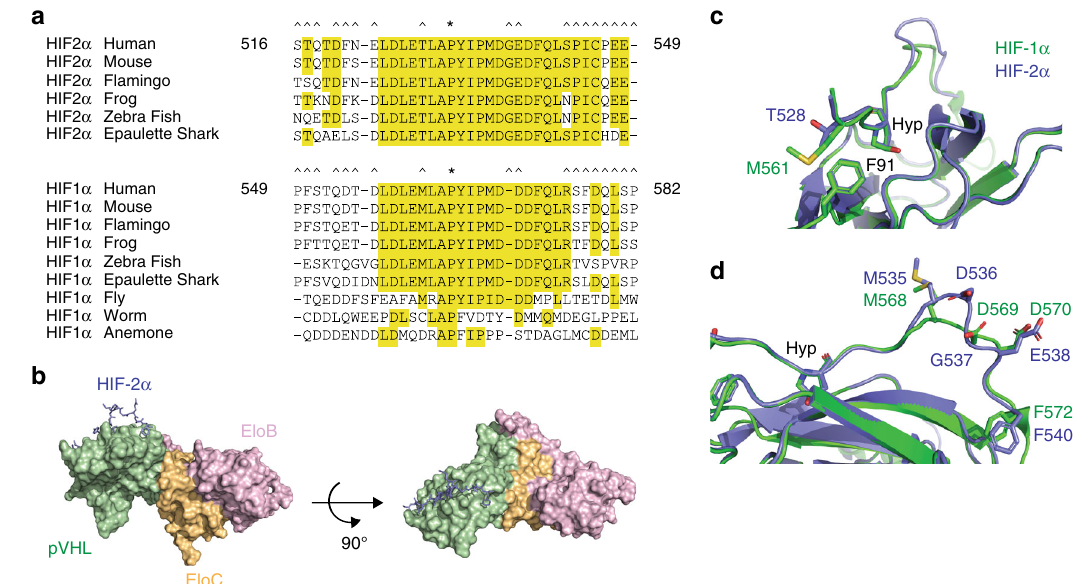
Fig. 2 HIF-1 α and HIF-2 α peptides bind VBC complex with a similar motif. a Alignment of HIF-1 α and HIF-2 α proteins from various species. *denotes the primary hydroxylation site. ^denotes residues that are not conserved between human HIF-1 α and HIF-2 α . Residues shaded in yellow are conserved in at least two out of three species for that protein. b Model of pVHL-elongin B-elongin C-HIF-2 α OH complex. HIF-2 α is shown as a stick model in light blue. pVHL (green)-elongin B (pink)-elongin C (yellow) are displayed as a van der Waal surface. c , d Crystal structures of pVHL-elongin B-elongin C-HIF-1 α OH complex (1LQB) and pVHL-elongin B-elongin C-HIF-2 α OH complex are superimposed. Carbon is shown in green (HIF-1 α ) or light blue (HIF-2 α ), oxygen is shown in red, nitrogen is shown in blue, and sulfur is shown in